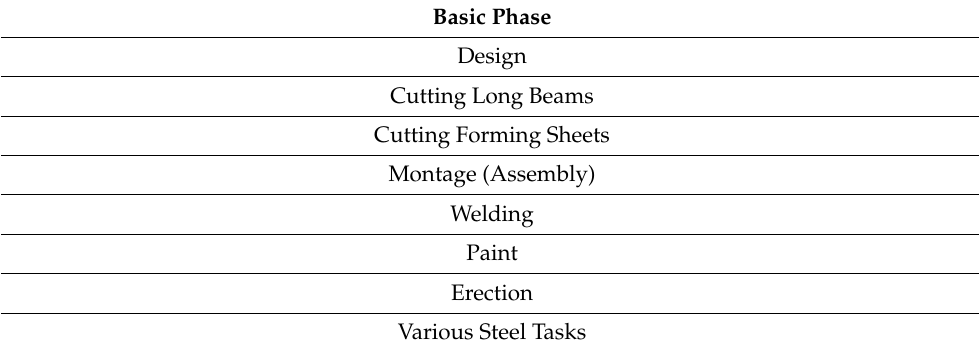
Table 1. Basic phases of steel structures.